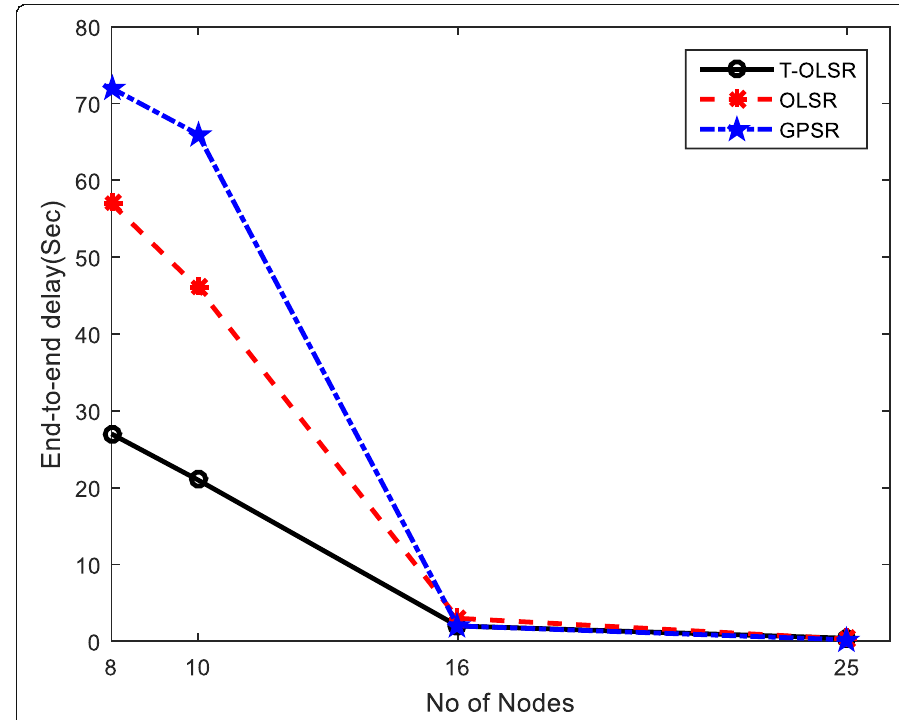
Fig. 11 End-to-end delays performance of T-OLSR ( Ф = 2 s, τ = 10 s), OLSR, and